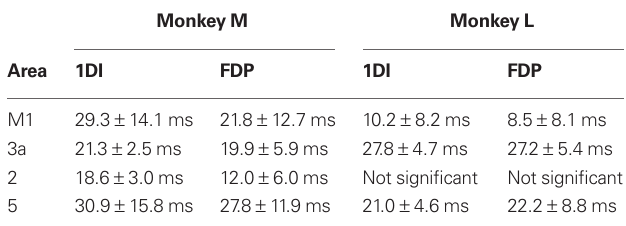
Table 1 | Phase delays for corticomuscular